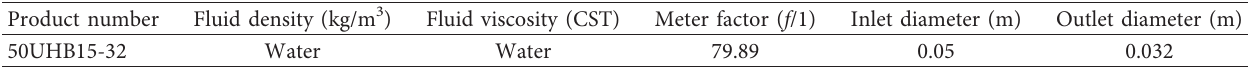
Figure 12: Pump performance test bench. Table 3: Parameter settings of pump performance experiment.